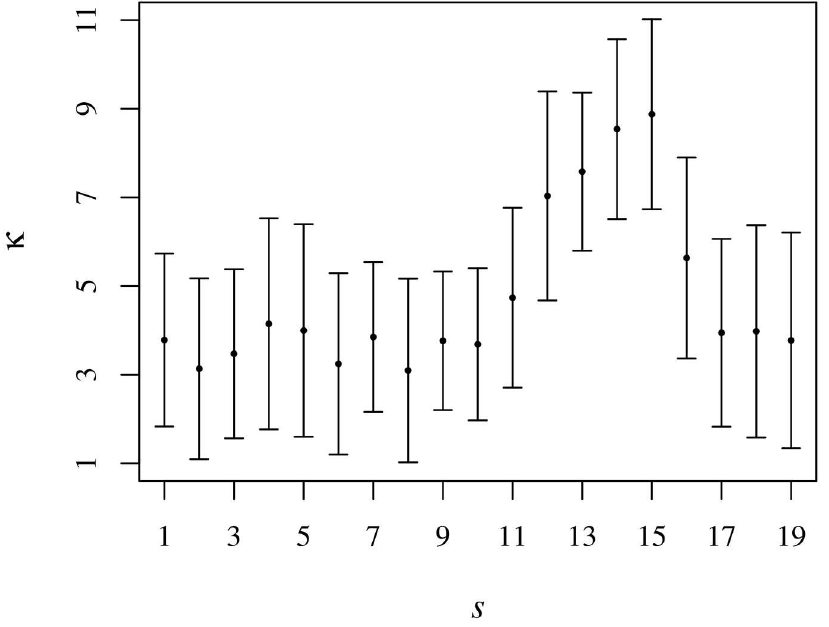
Fig 15. Intraday cross-sectional kurtosis v semester s . The symbols (and the bars) represent ^ k ð t ; s Þ averaged over intraday time with t >